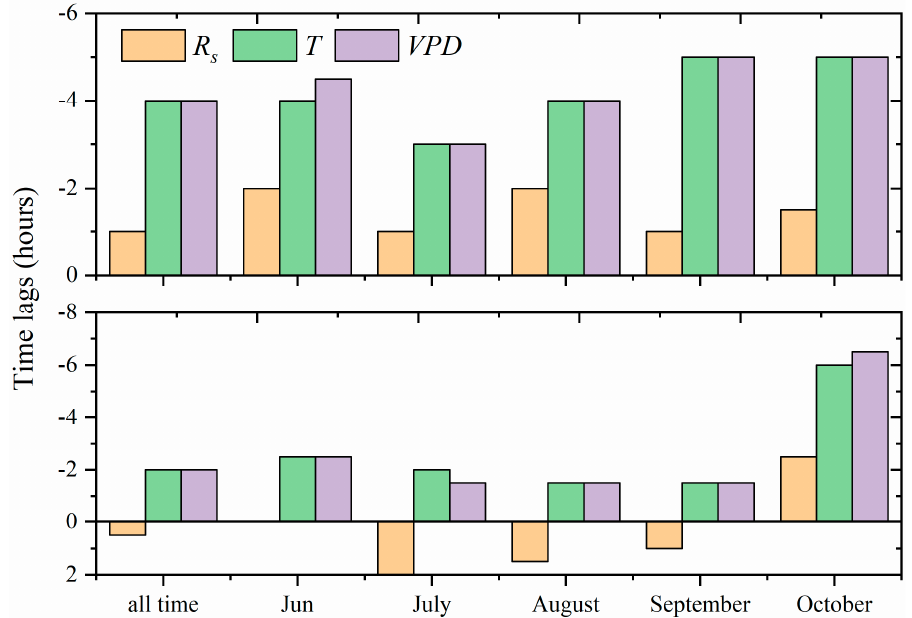
Figure 4. Time lags between maximum stand transpiration and environmental variables including solar radiation ( R s ), temperature ( T ), and vapor pressure deficit ( VPD ) for different months in ( a ) 2014 and ( b ) 2015. Positive values indicate that maximum stand transpiration occurred later than maximum environmental variable.